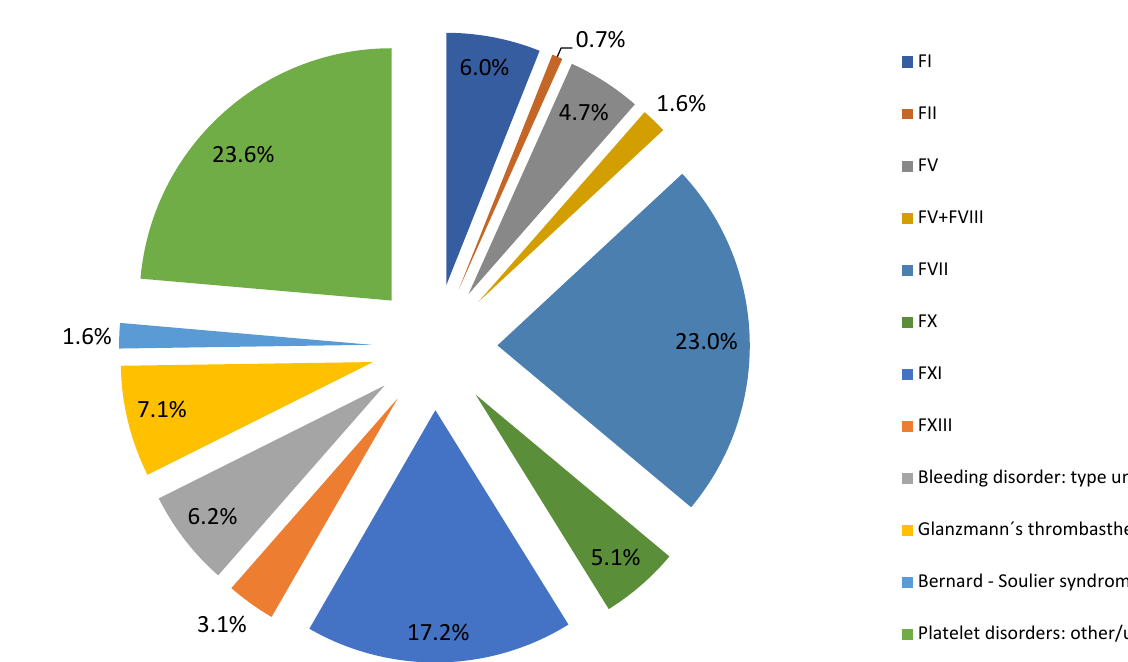
Figure 1. Worldwide distribution of RBDs derived from the WFH survey 2019.